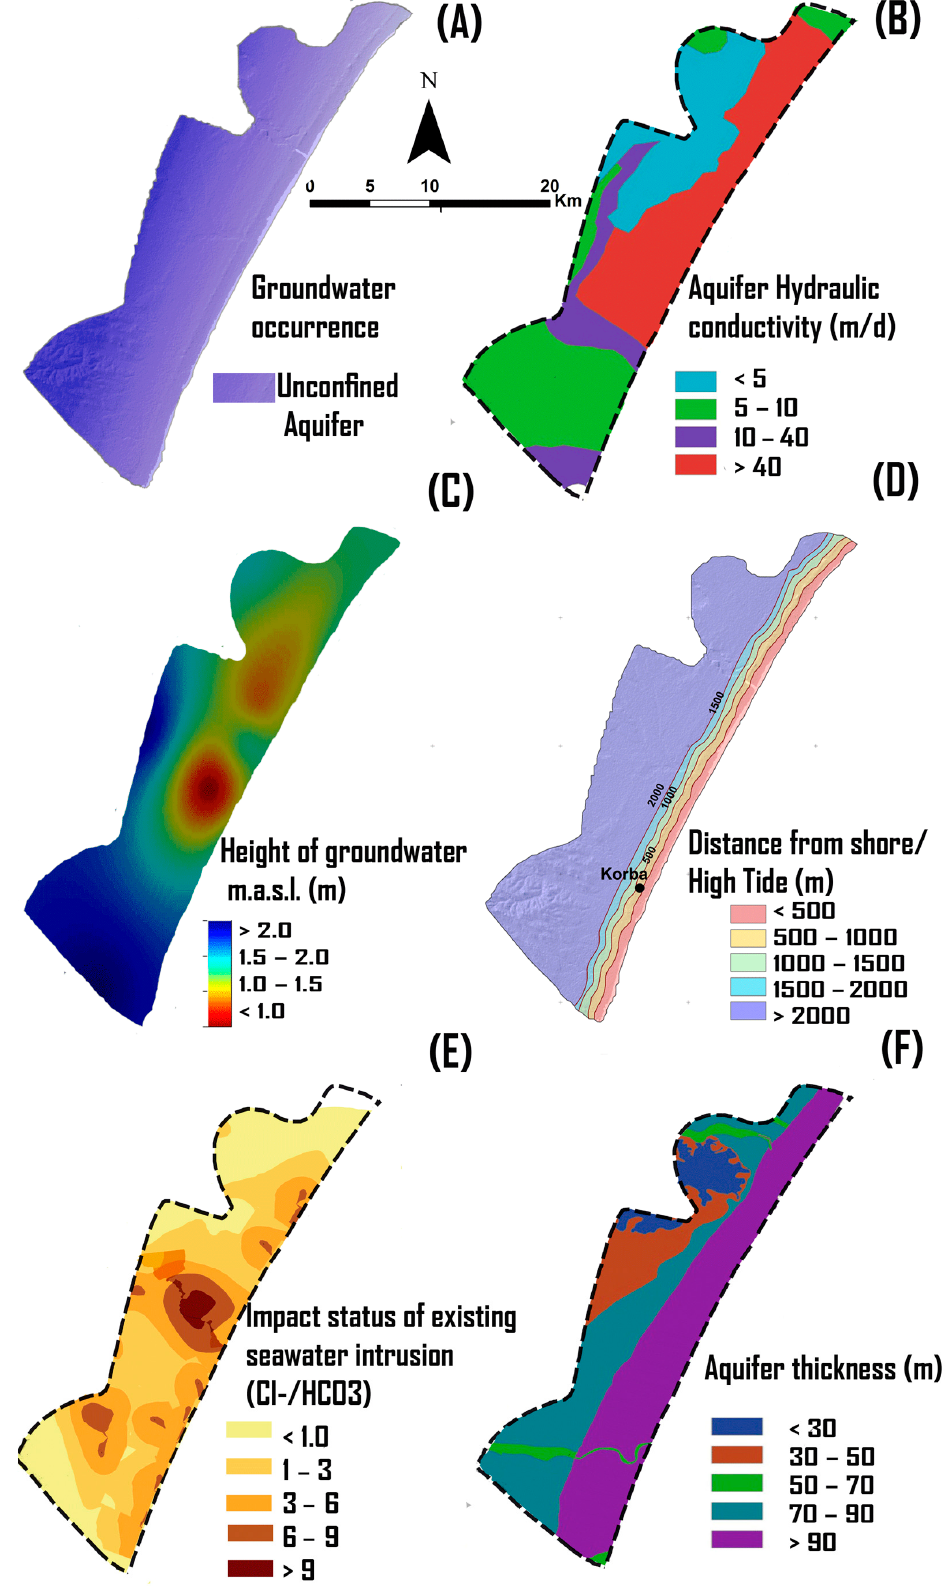
Figure 3. The six layers of GALDIT parameters of Korba aquifer.